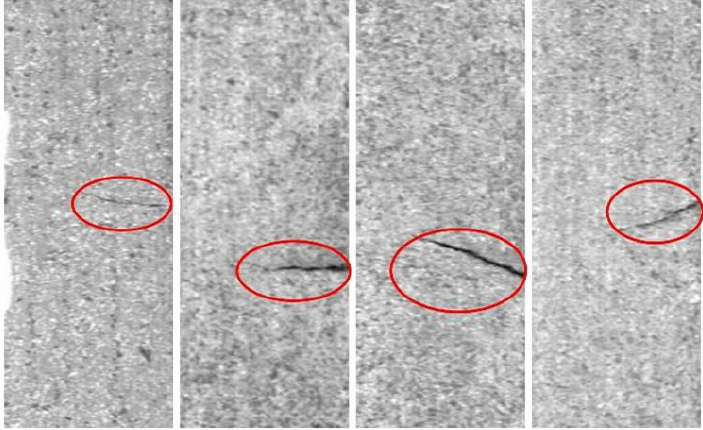
Figure 13. The image samples in the KolektorSDD dataset. Defects are marked with red